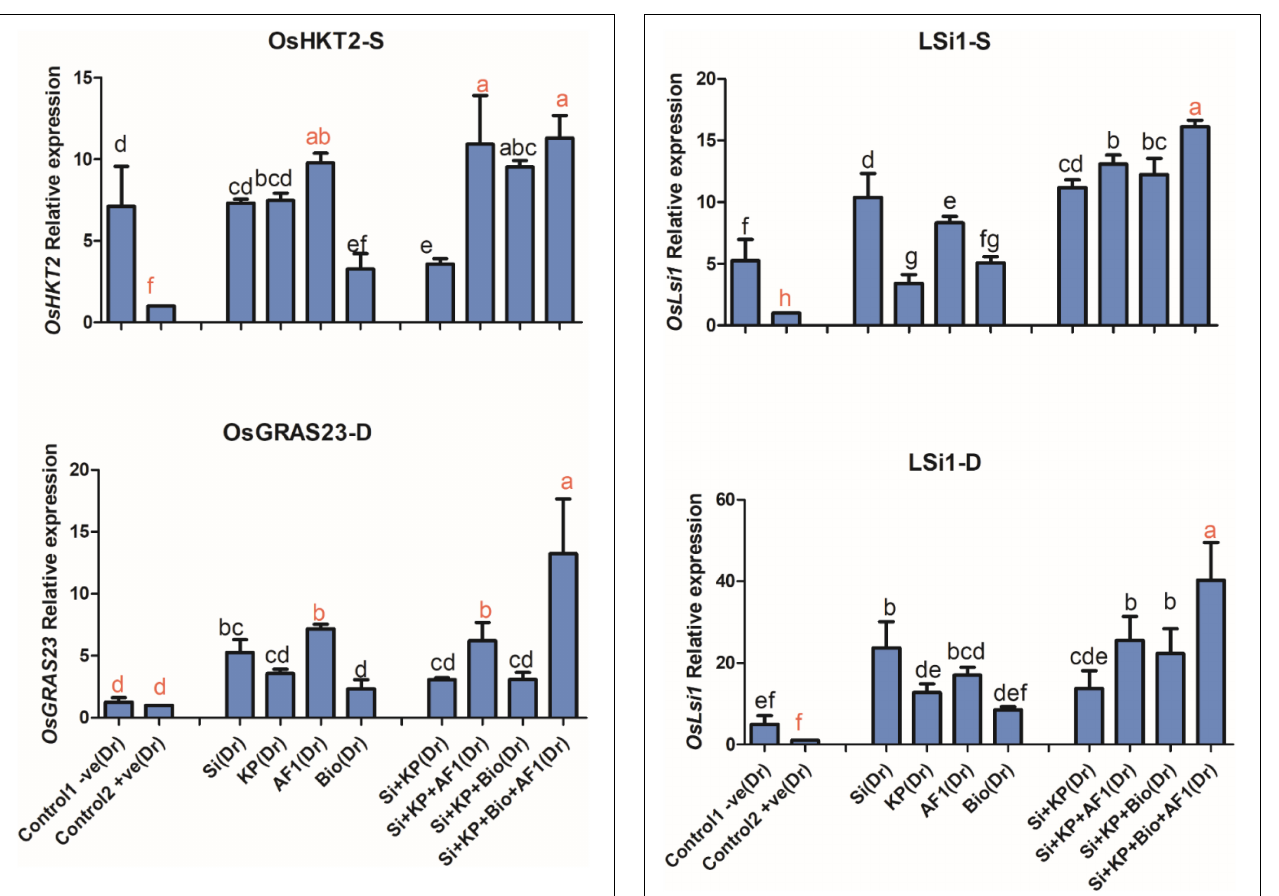
FIGURE 10 | Expression level of the silicon-carrying gene OsLSi1 in rice shoots subjected to salt and drought stresses following the sole and co-application of AR11, Si, K 2 HPO 4 , and biochar. (-S), salt; (-D), drought. Error bars represent standard deviations. Each data point represents the mean of at least three replications. Bars with different letters are significantly different from each other at P ≤